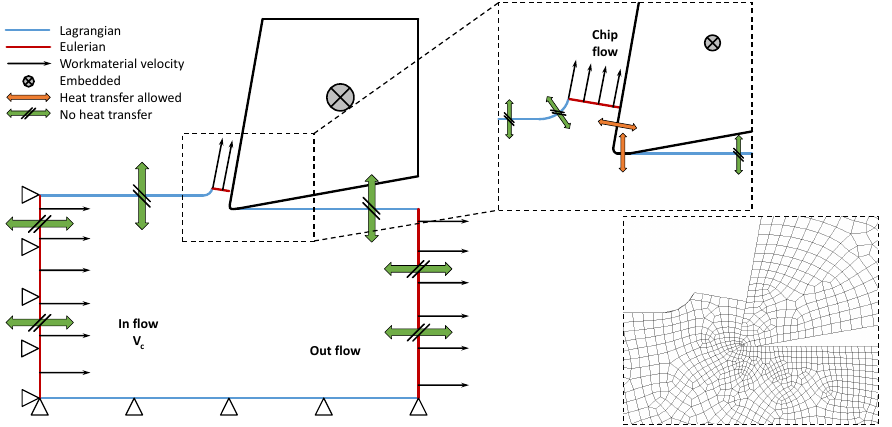
Figure 2. Description of the Arbitrary Lagrangian–Eulerian model and detail of the mesh. In the FE simulations, four-node bilinear plane strain thermally coupled quadrilateral elements with bilinear displacement and temperature, reduced integration were